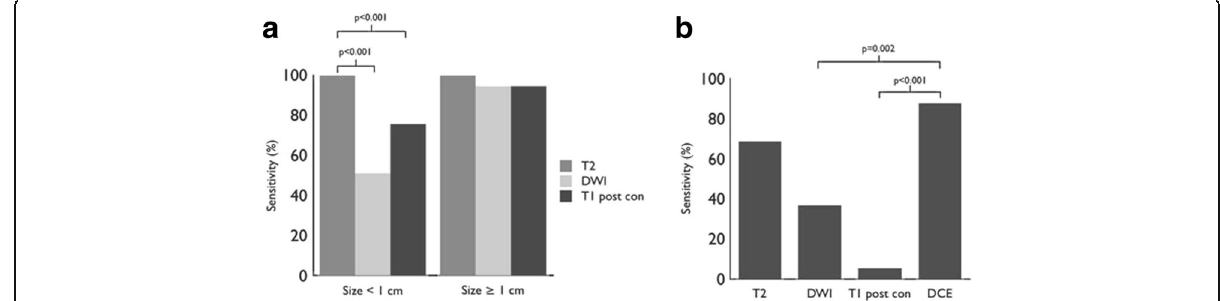
Fig. 1 Detection rate for abdominopelvic lymph nodes by size and MRI sequence ( a ). Small FOV T2, DWI, and T1 post-contrast images identify nearly all PSMA-positive lymph nodes greater than 1 cm. Small FOV T2 is more sensitive than DWI or T1 post-contrast images for lymph nodes less than 1 cm ( p < 0.001). Detection rate for prostate bed recurrence by MRI sequence ( b ). Dynamic contrast-enhanced imaging (DCE) is more sensitive than DWI or single-phase T1 post-contrast images for suspected PSMA-avid prostate bed recurrence ( p = 0.002 and p < 0.001, respectively). The difference in sensitivity between DCE and T2 was not statistically significant ( p > 0.05)